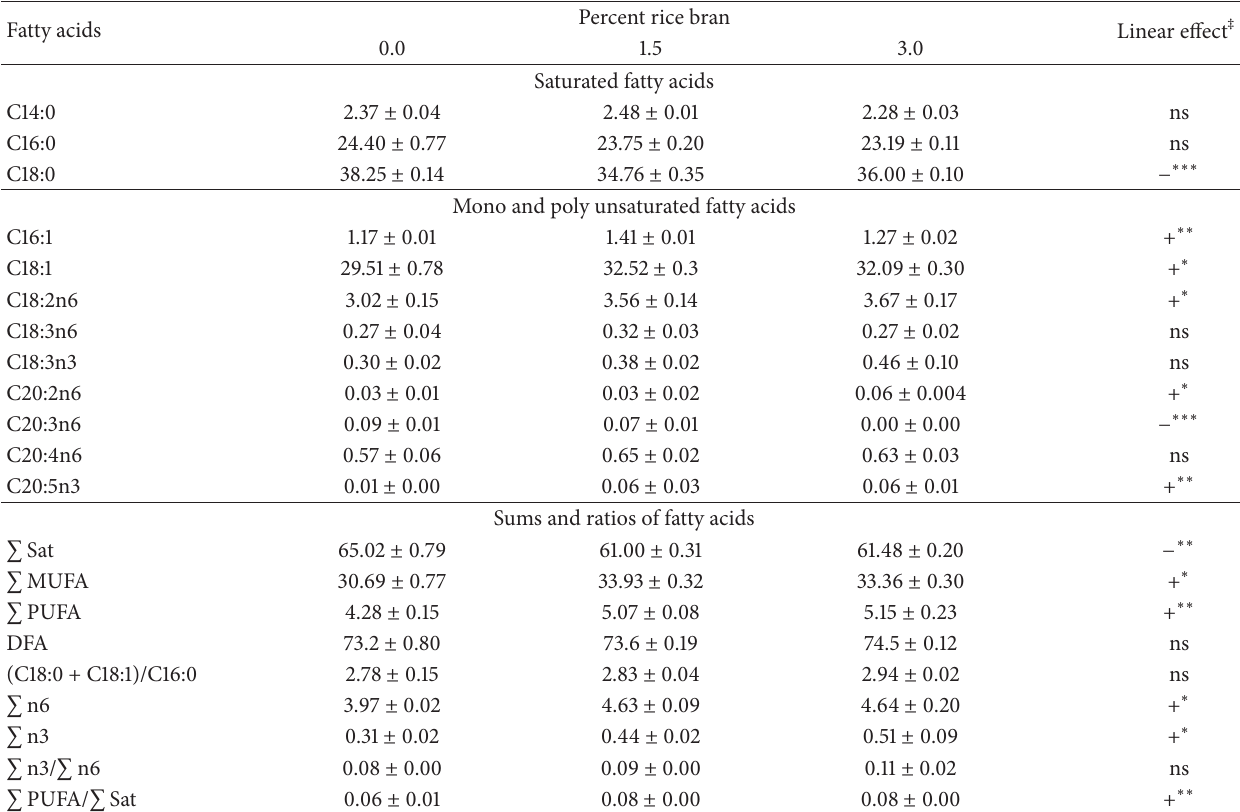
Table 3: Fatty acid composition of cooked goat meat sausages with added rice bran (Means ± s.e.) § . Fatty